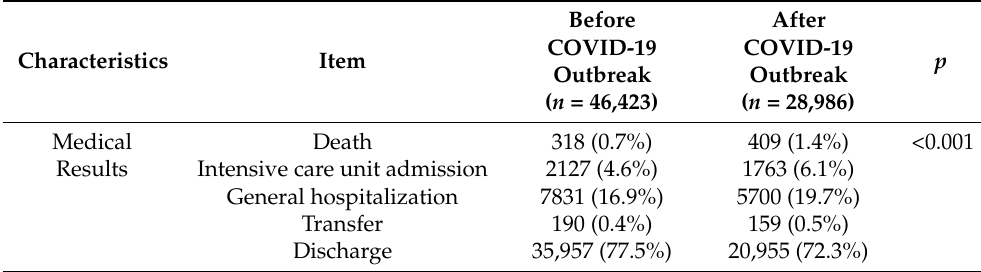
Table 4. Medical results of patients visiting the emergency room before and after the outbreak of